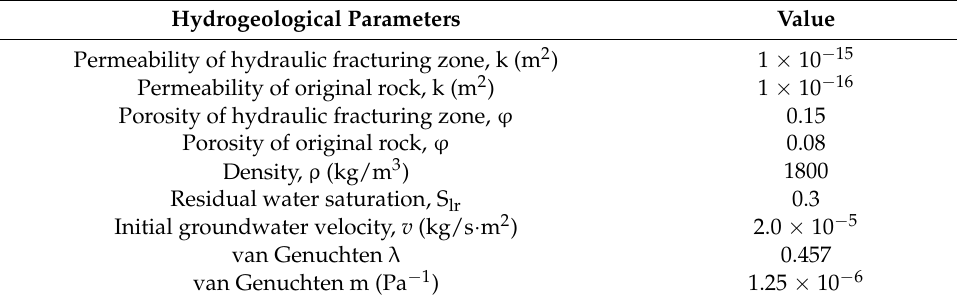
Table 1. Hydrogeological parameters of the